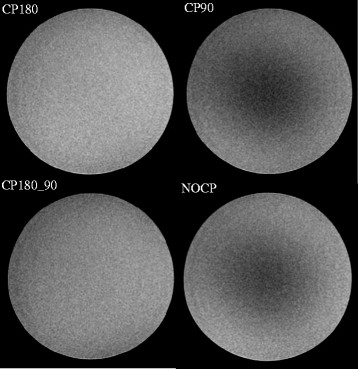
PDw phantom images using varying iMSDE RF pulse types with identical windowing. Composite 180° only (CP180), composite -90° only (CP90), composite 180° and composite -90° (CP180_CP90), and no composite RF pulses (NOCP). Sinusoidal gradients with a first order moment of 487 mT*ms2/m were used.